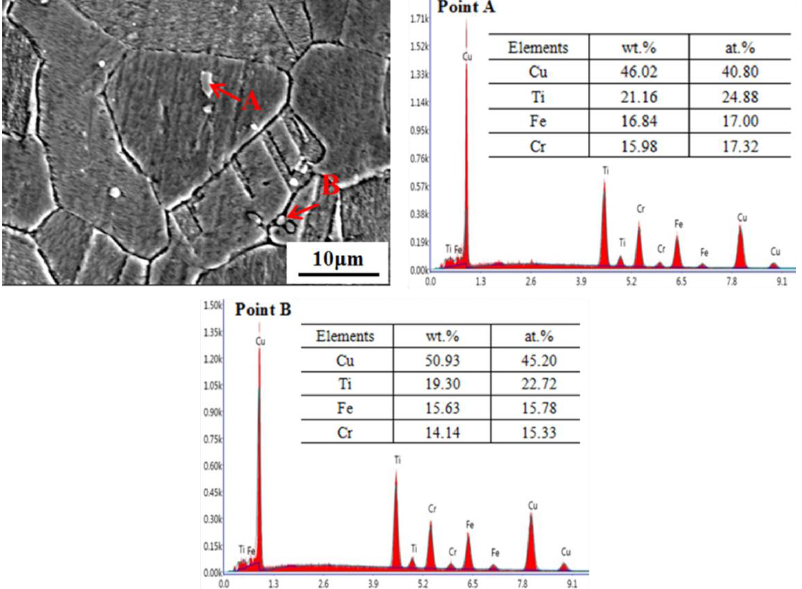
Figure 1 . Optical micrographs of the solution-treated specimens, at 900 °C, for 4 h. ( a ) Cu-3Ti; ( b ) Cu- Ti-Fe; and ( c ) Cu-Ti-Fe-Cr.